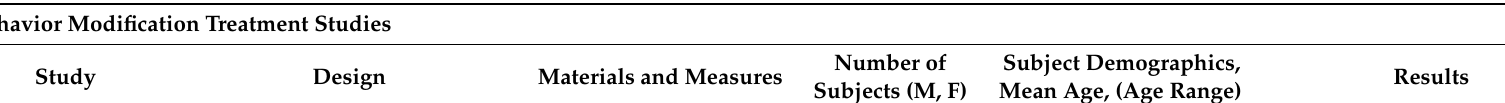
Table 1. Summary of onychophagia treatment